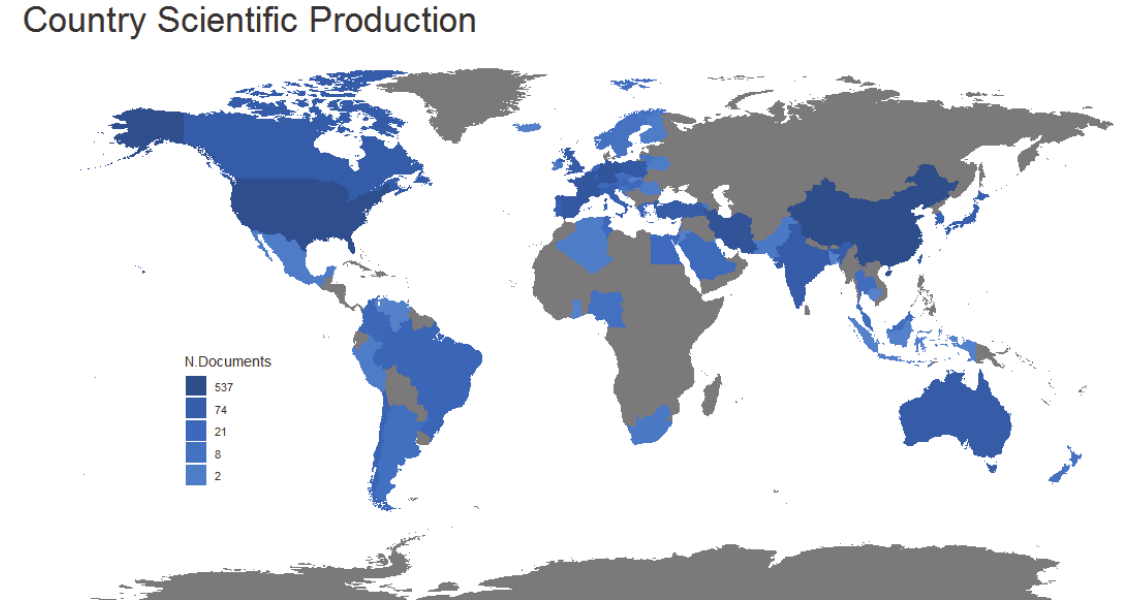
Fig. 5. The frequency of the keywords used in different project scheduling